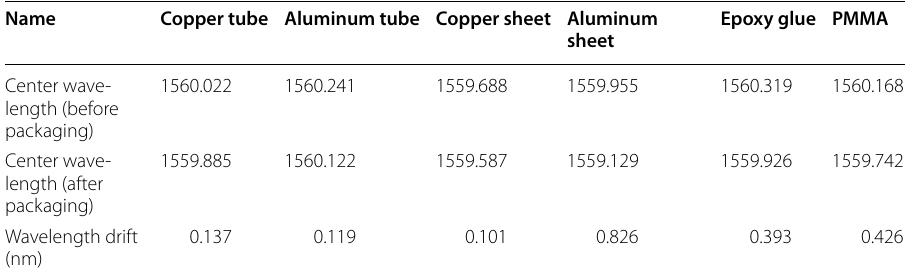
Table 2 The drift of the center wavelength of the fiber grating before and after encapsulation with different substrate materials